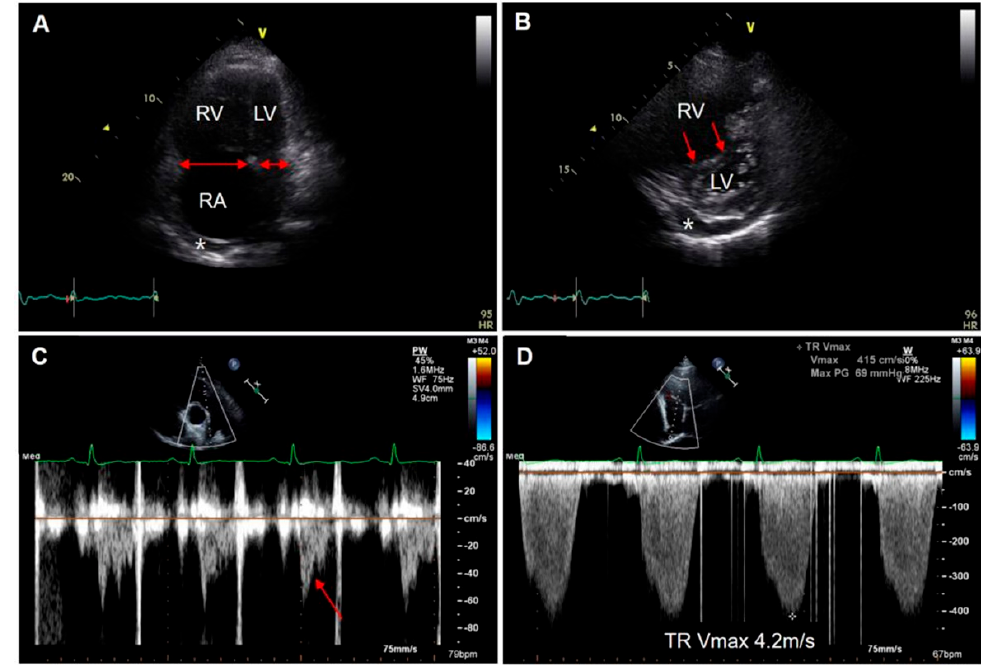
Figure 3. Echocardiographic findings associated with CTEPH. Note the dilated RV ( A ) and flattened interventricular septum (called the D-shaped LV, red arrows), which suggest RV pressure overloading ( B ). Pericardial effusion (asterisk) can be observed in advanced cases of CTEPH ( B ). Pulsed-wave Doppler image obtained from the RV outflow tract shows a midsystolic notch (arrow) and shortened acceleration time, which reflect increased pulmonary vascular resistance ( C ). Continuous-wave (CW) Doppler analysis at the tricuspid valve reveals a TR Vmax of 4.2 m/s, which strongly suggests significant PH ( D ).